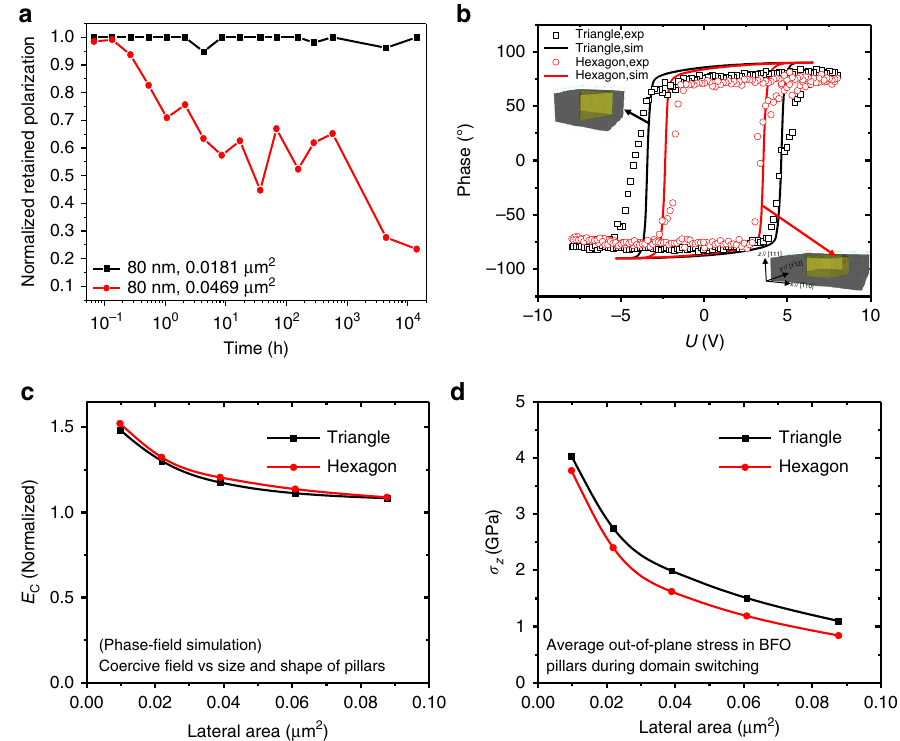
Figure 4 | Polarization retention loss mechanism. ( a ) Comparison of normalized retained polarization versus the relaxing time between BFO nanocrystals with different sizes. ( b ) Polarization phase changes as a function of electric fields. The open rectangles and circles represent experimental data, and the black and red lines are phase-field simulation results. ( c ) Coercive field as a function of the lateral area of the BFO mesocrystals with different shapes. The coercive field is normalized with respect to that of the BFO mesocrystals with the same thickness. ( d ) Average OOP stress as a function of the lateral